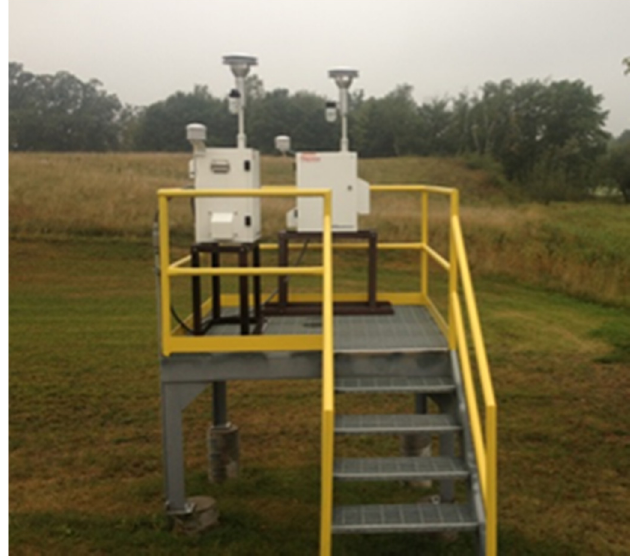
Figure 9. Primary and collocated Partisol 2000i samplers at the Chippewa Falls Location 1 site. The distances between the two sampling locations ranged from 780 m at the processing plant to 690 to 1300 m at the three mines. All eight of the sampling locations satisfied the sampling site criteria specified by the U.S. EPA in 40 CFR Part 58, Appendix E [11]. The two sampling locations were 10 to source within each